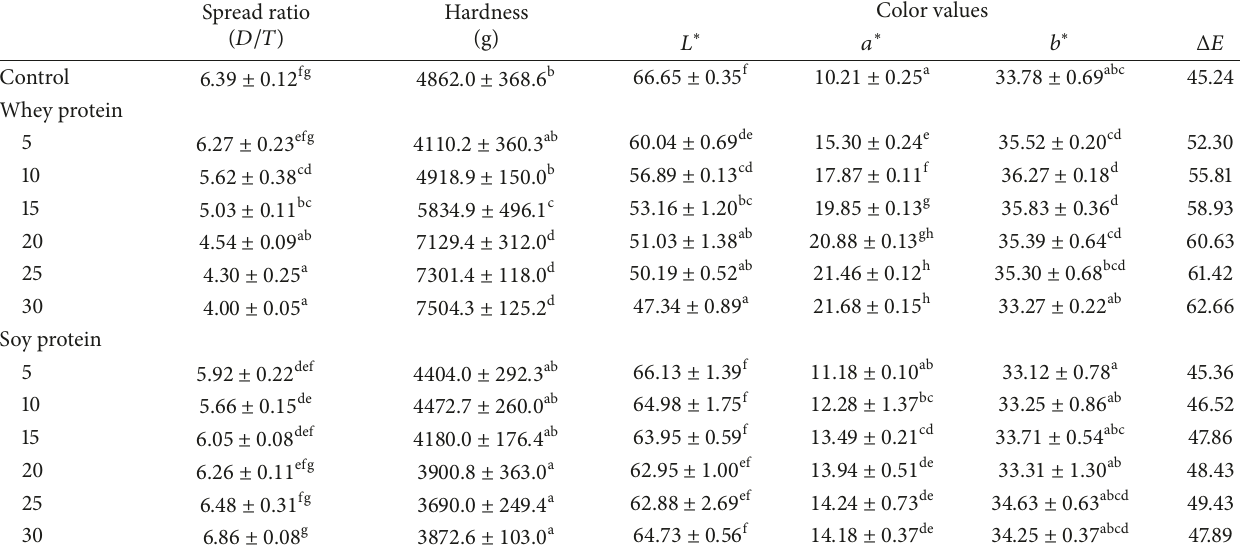
Table 2: Effect of whey and soy protein addition on cookie quality parameters a .